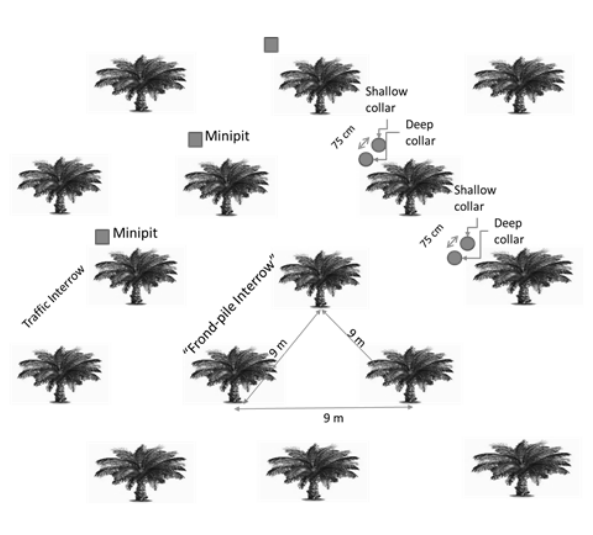
Figure 1. Schematic representation of closed chamber (collar) and minipit positions along the frond pile inter-rows and traffic inter-rows under mature oil palm trees. Schematic is not to scale to improve